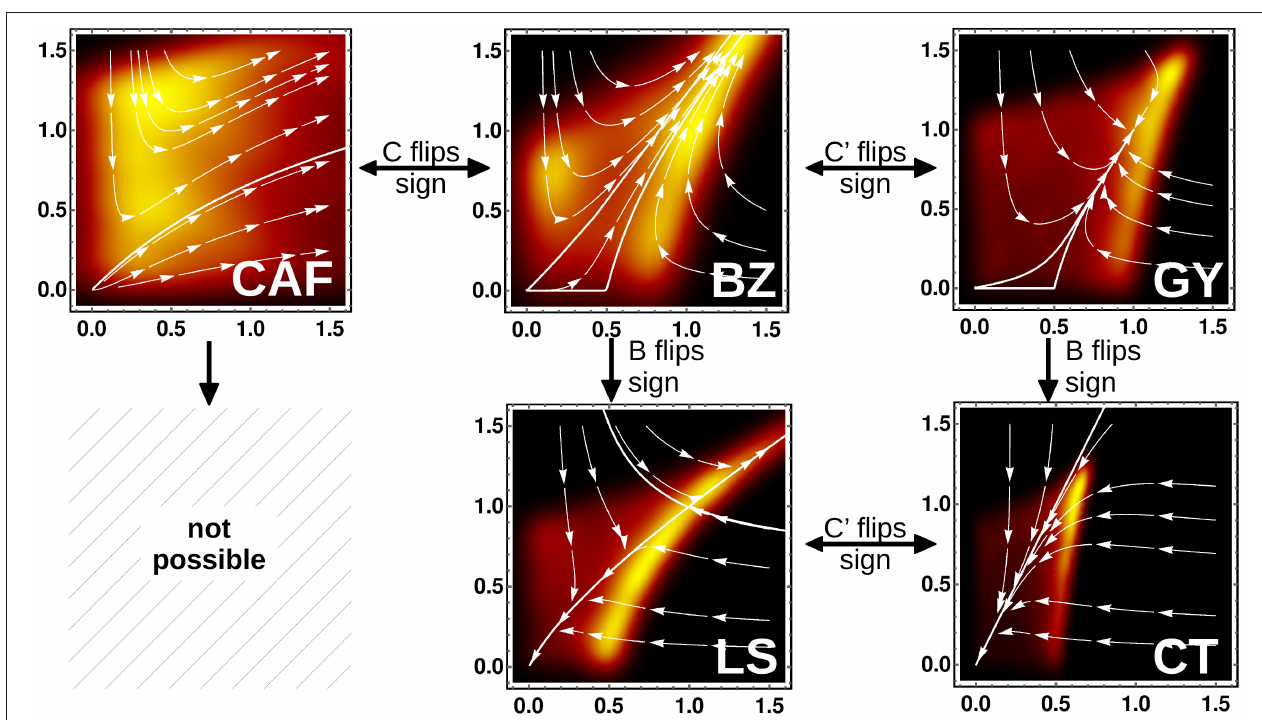
FIGURE 1 | Possible RG structures, cf. [73] (see main text for further discussion), of simple gauge Yukawa-theories, depending on the signs of one- and two-loop coefficients B , C , and C ′ of the gauge coupling β -function, cf. Equation (4) and in turn on the gauge group and matter content of the theory. The x-axis (y-axis) shows the gauge coupling α g (Yukawa coupling α y ). Thick white lines indicate the boundary surface of the UV-complete, IR-complete, or conformal regions in theory space. White flow lines (arrows) point toward the IR. The heat maps in the background indicate how a set of random EFTs, uniformly distributed over the full depicted range of couplings, is focused toward the boundary surface. Lighter areas indicate a high density of theories one order of magnitude below the cutoff scale. The explicit C C ′ E F / 2 C F β -function coefficients, cf. Equation (4), required to obtain the plots have been chosen as: CAF: B 1 / 10; BZ: 2 B 2 C ′ 2 E 1; = = = = = = − = = = = C C C GY: 2 B 2 C ′ 2 E 2 F 1; LS: 2 B 2 C ′ 2 E 2 F 1; CT: 2 B 2 C ′ 2 E 2 F = − = − = = = − = − = = = = − = − = − = = =